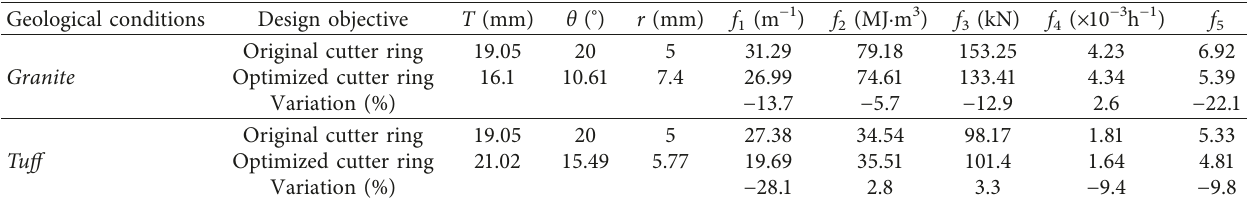
Table 6: Optimization results of structural parameters for the cutter ring.